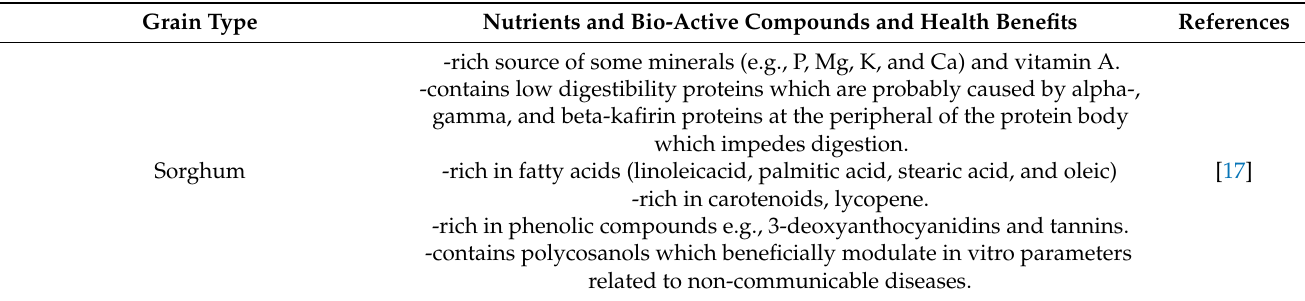
Table 1. Summary of the nutrients and bio-active compounds and their benefits in selected gluten-free grains. Grain